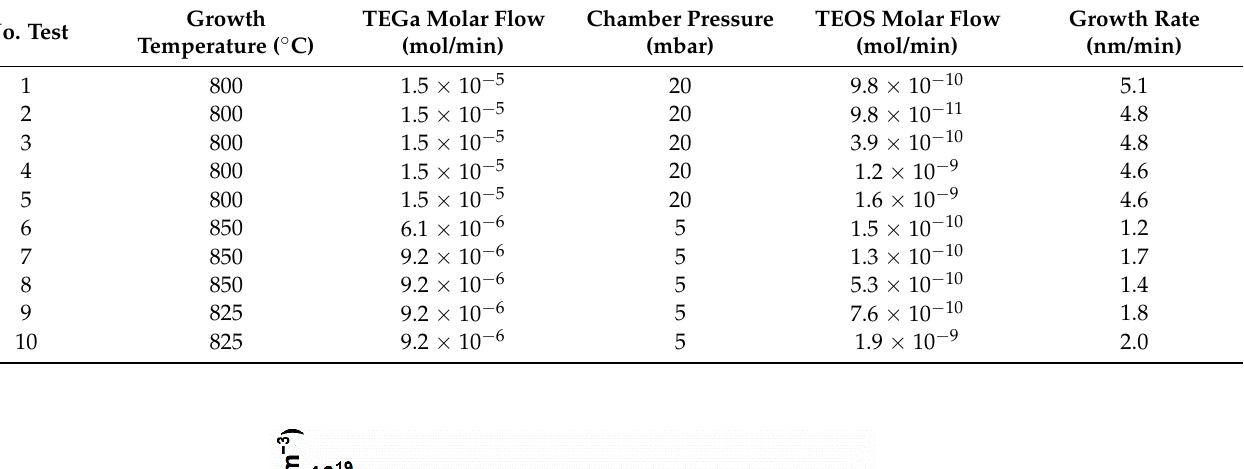
Table 2. Experimental parameters for the model validation on (010) β -Ga 2 O 3 thin films. The corresponding process parameters are listed below. The experimental results and detailed mechanism in Table 2 are referred to Refs. [12,46].